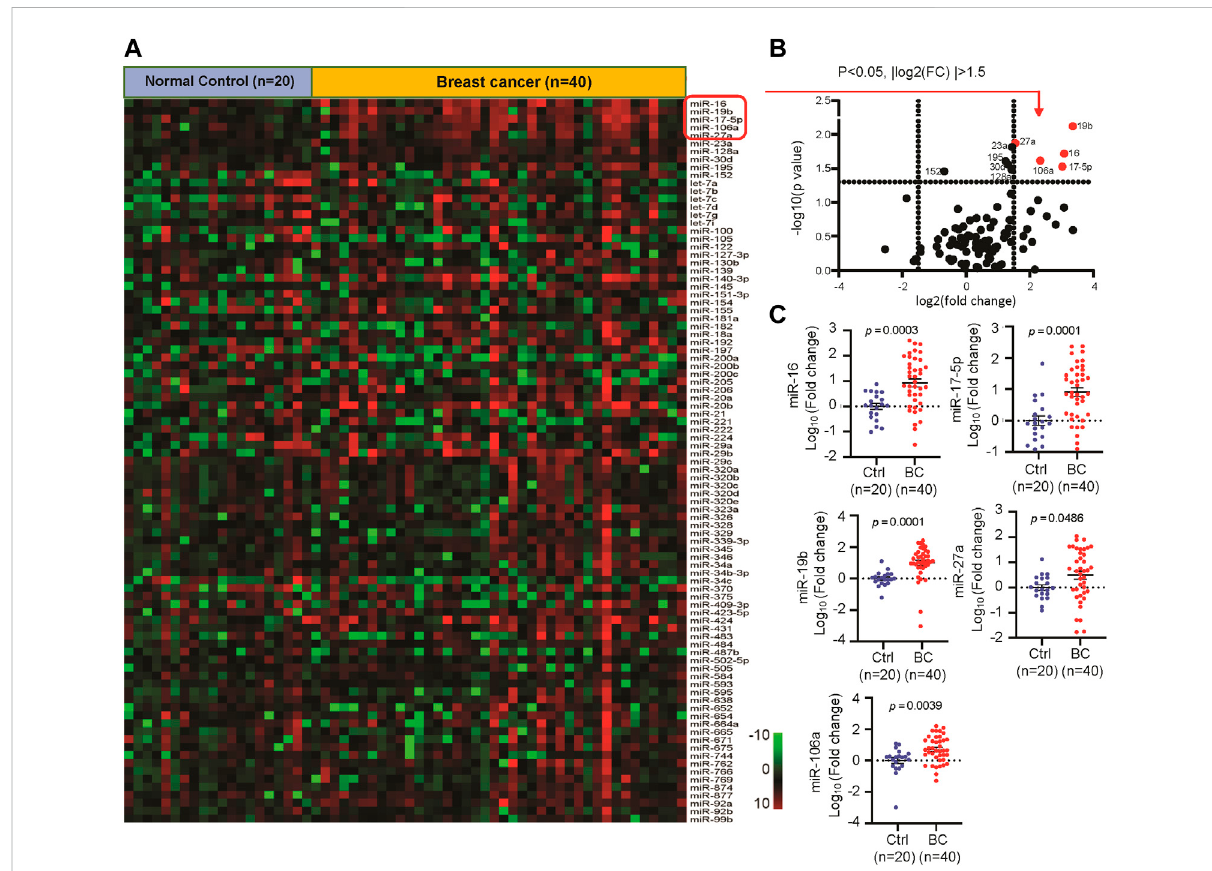
FIGURE 2 Identi fi cation of the differentially expressed circulating miRNAs in breast cancer (BC) patients. (A) . Heatmap of a quantitative RT-PCR based screening analysis of circulating miRNAs in the plasma of BC patients ( n = 40) and normal controls ( n = 20). (B) . Volcano plot reporting p values against fold changes, in which -log 10 ( p -value) for miRNAs ( Y -axis) plotted against their respective log 2 (fold change) ( X -axis). 10 miRNAs with signi fi cant change ( p < 0.05) were labeled with ID. The red dots represented top fi ve up-regulated miRNAs in BC. (C) . The relative expression levels of circulating miR-16, miR-17, miR-27a, miR-19b and miR-106a in 40 BC and 20 control